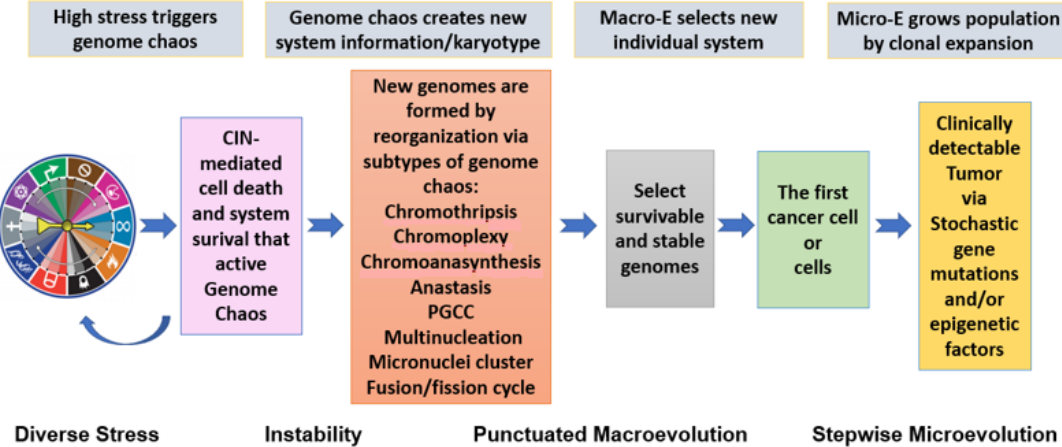
Figure 1. New model of two-phased cancer evolution . Diverse stresses are represented by the hallmarks of cancer (modified from [90,127]). When stress is high enough to kill cells, it can trigger genome chaos. Genome chaos can manifest as many subtypes, both structural and numerical, of which only seven examples are listed here. Regardless of the individual subtypes, new system information is created. Evolution selects the first cancer cell or the first wave of cancer cells, which are then subject to microevolution to grow the cancer cell population. This process can be linked to large numbers of different gene mutations or pathways. For more information, please refer to